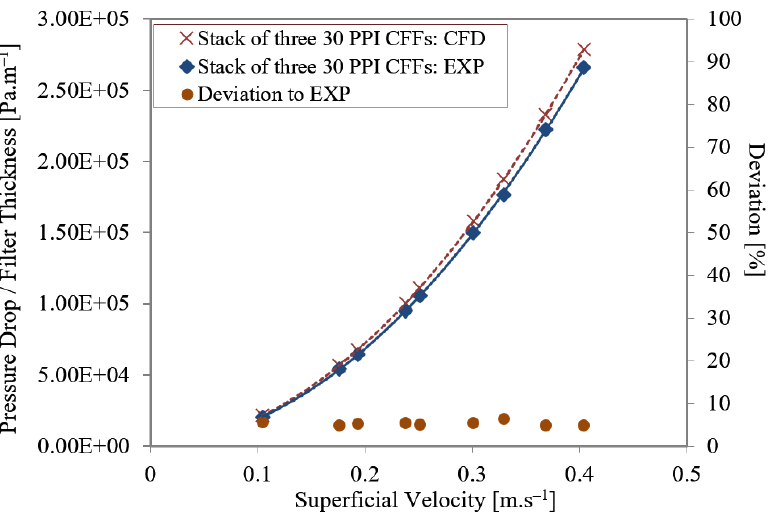
Figure 8. Comparison between the experimentally obtained (the solid curves) and the CFD esti- mated (the dotted curves) pressure gradients of the well-sealed stacks of three 30, 50 and 80 PPI CFFs.